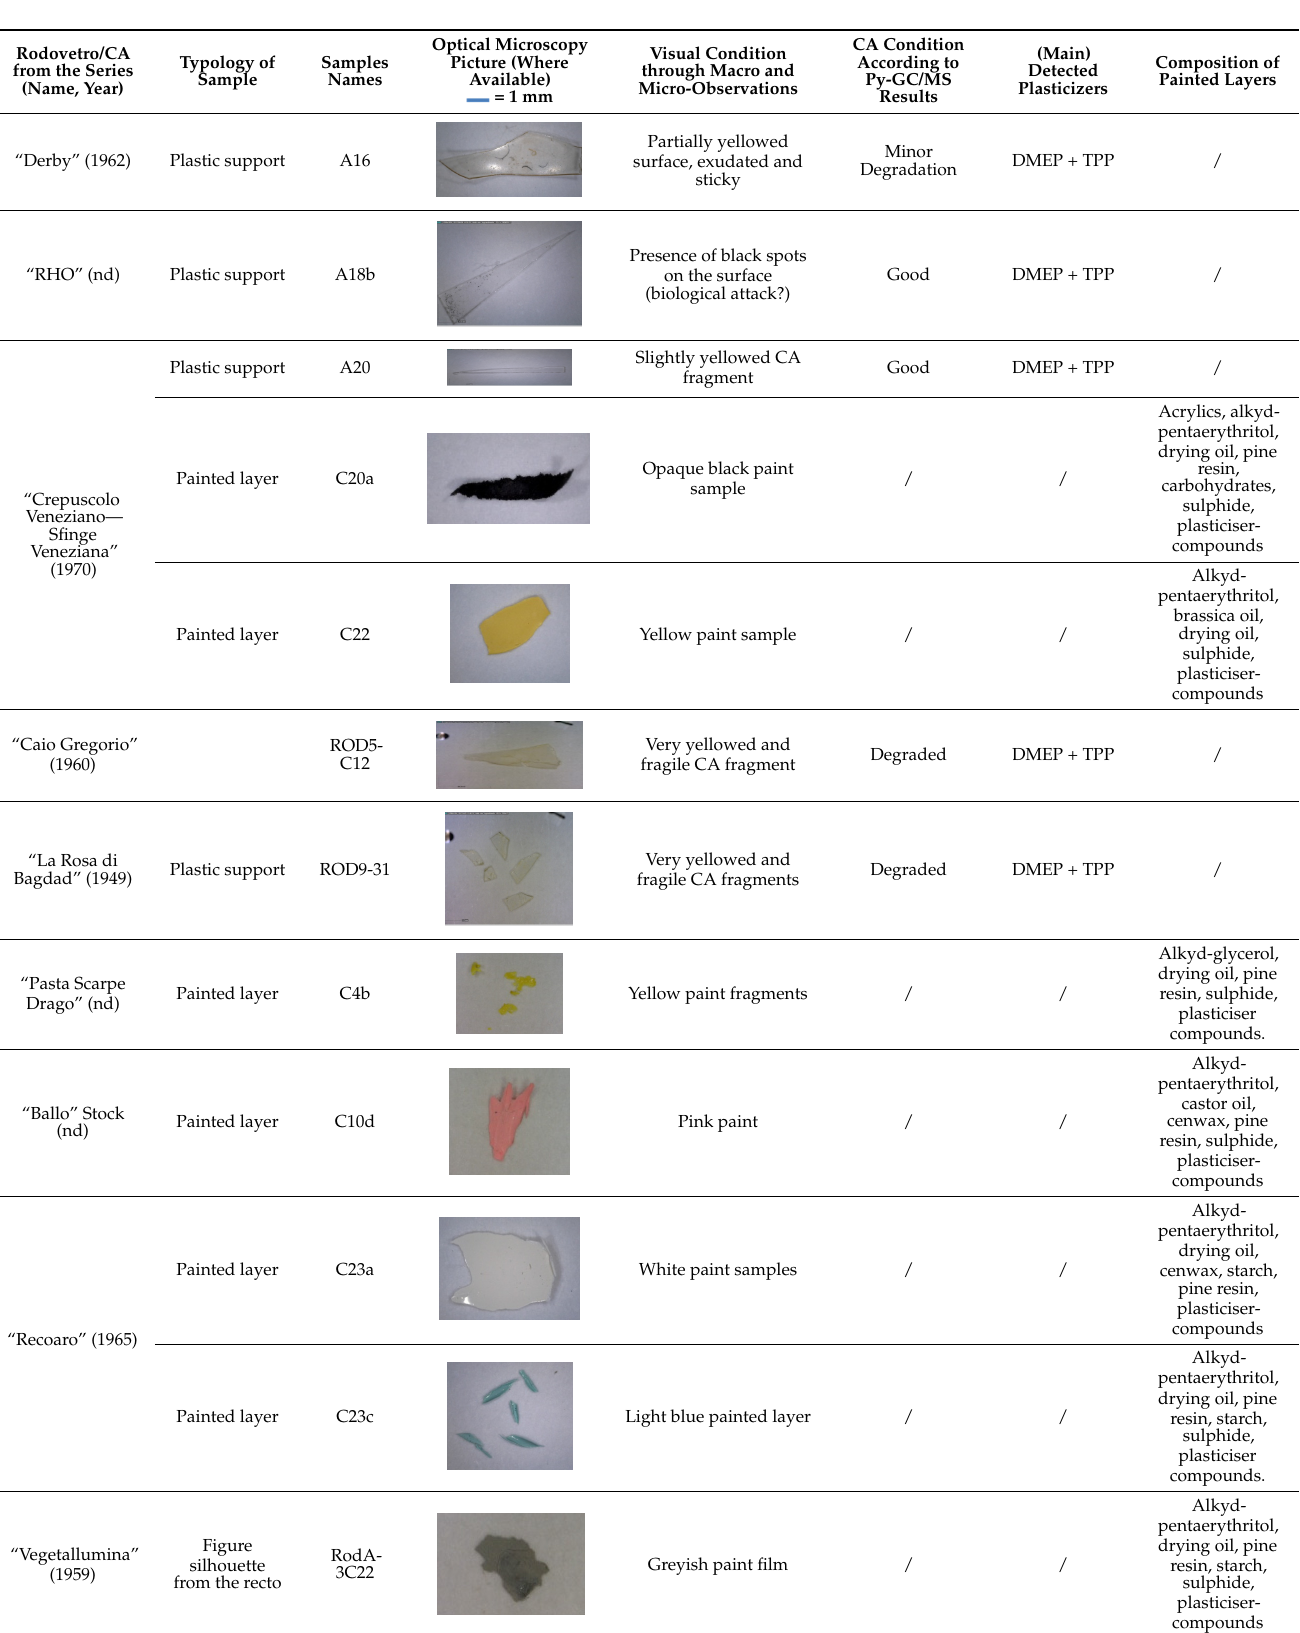
Figure 1. Visible light images of the analyzed Rodovetri: ( a ) La Rosa di Bagdad (1949), ( b ) Vegetallumina (1959), ( c ) Caio Gregorio (1960), ( d ) Brandy Gran Senior (1974), ( e , f ) Serie Stock (nd). The animation cels exhibit several degradation phenomena which compromise in many cases the stability of the plastic support and the readability of the characters. Table 1 lists the samples of the animation cels selected for research, taken from both the plastic supports (cellulose acetate sheets) and from painted layers. These Rodovetri were created between 1949 and 1972 and represented the main characters of short, animated advertising spots. Table 1. Cel, description, visual inspected condition, condition by Py-GC/MS results, plasticizers added, paint composition formulation. DMEP = bis(2-methoxyethyl) phthalate; TPP = triphenyl Table 1. Cont. phosphate; DMP = Dimethyl phthalate; DEP = Diethyl phthalate.